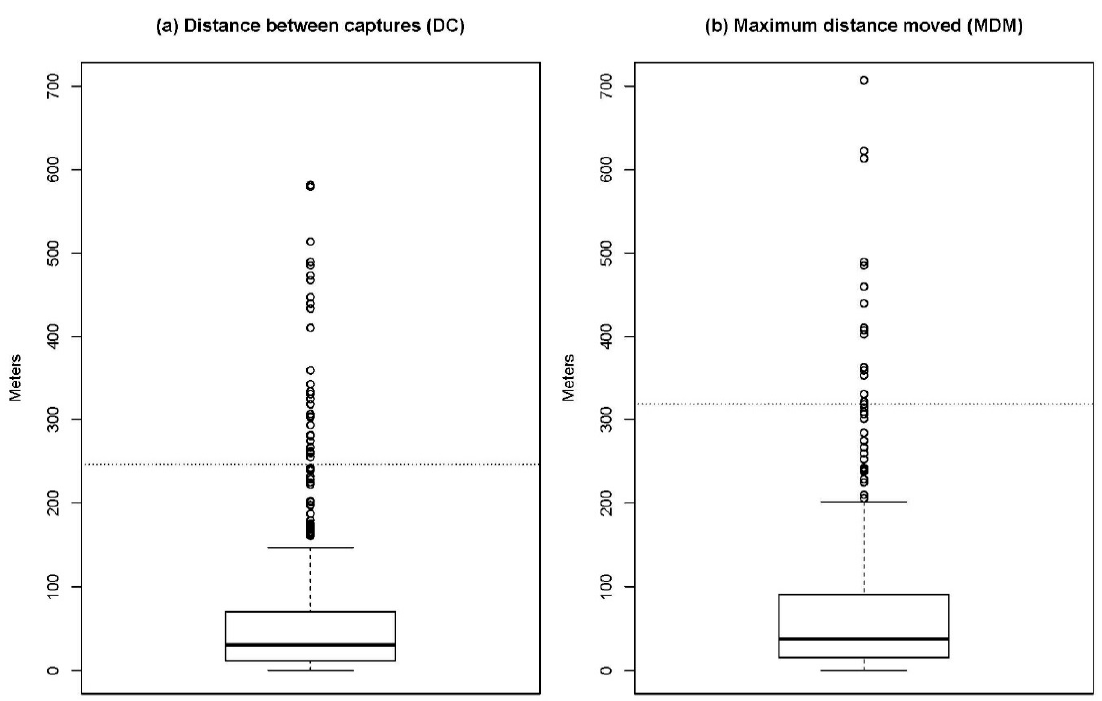
Figure 2. Absolute values (in m) for specimens recaptured once or more during the study period: ( a ) Distance between Captures (DC, observed movements), outliers between 158.70 and 246.91 m (dotted line) and extreme values from this last distance; ( b ) Maximum Distance Moved (MDM), outliers between 204.63 m and 318.3 m (dotted line) and extreme values from this distance onwards.